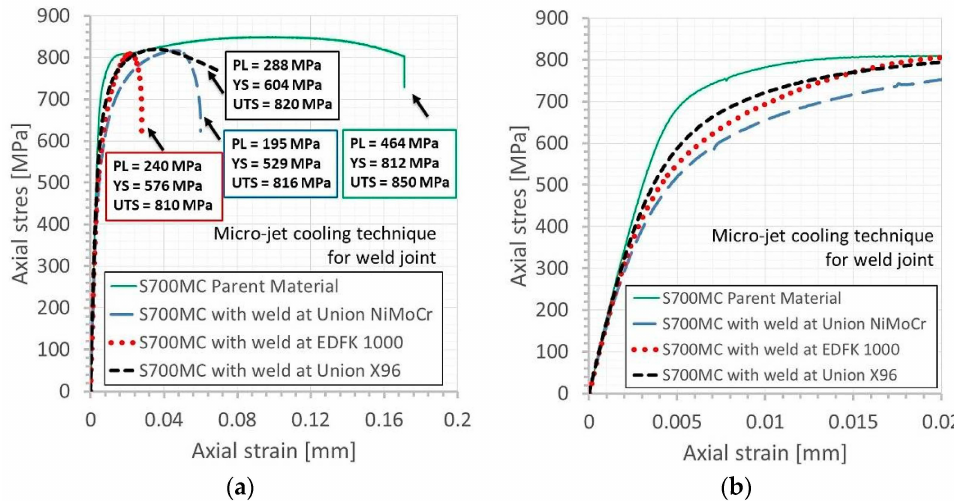
Figure 9. Tensile characteristics of S700MC welded by means of three different welding wires in: ( a ) general view, ( b ) focuses on elastic and elastic-plastic regions.